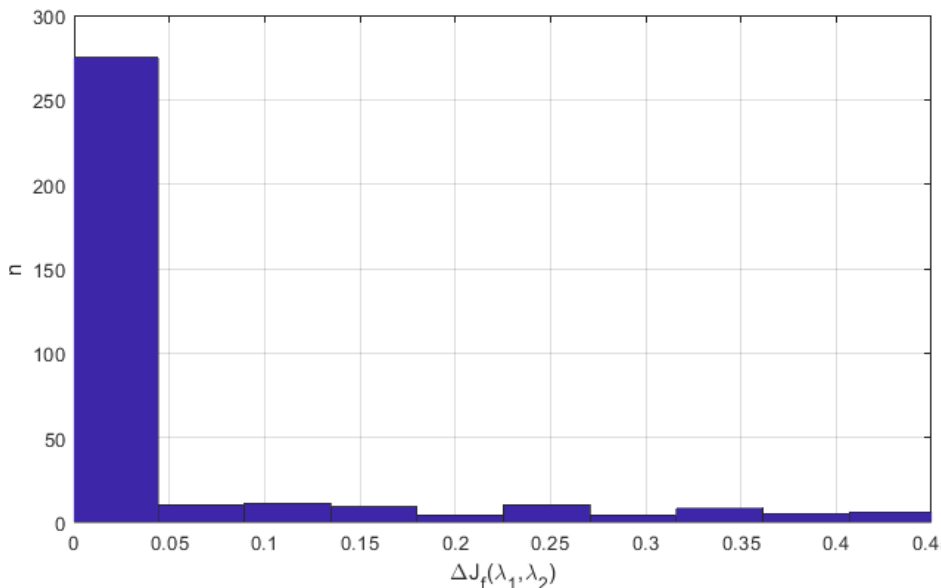
Figure 6. Histogram of additional errors caused by using of fractional lag filter.